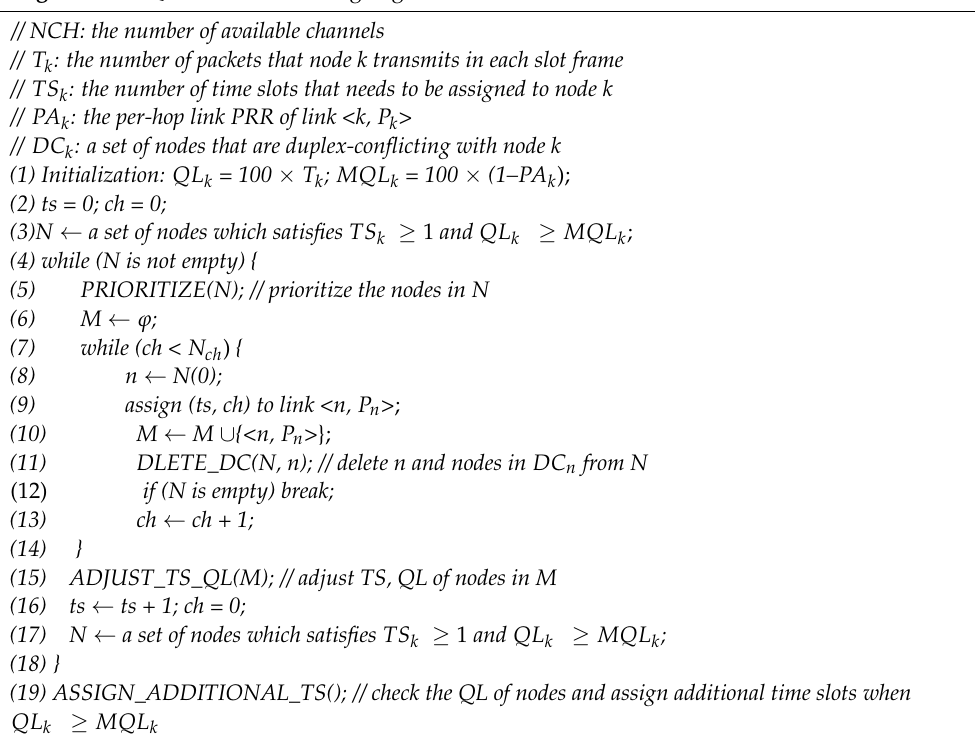
Algorithm 1: QL-Based Scheduling